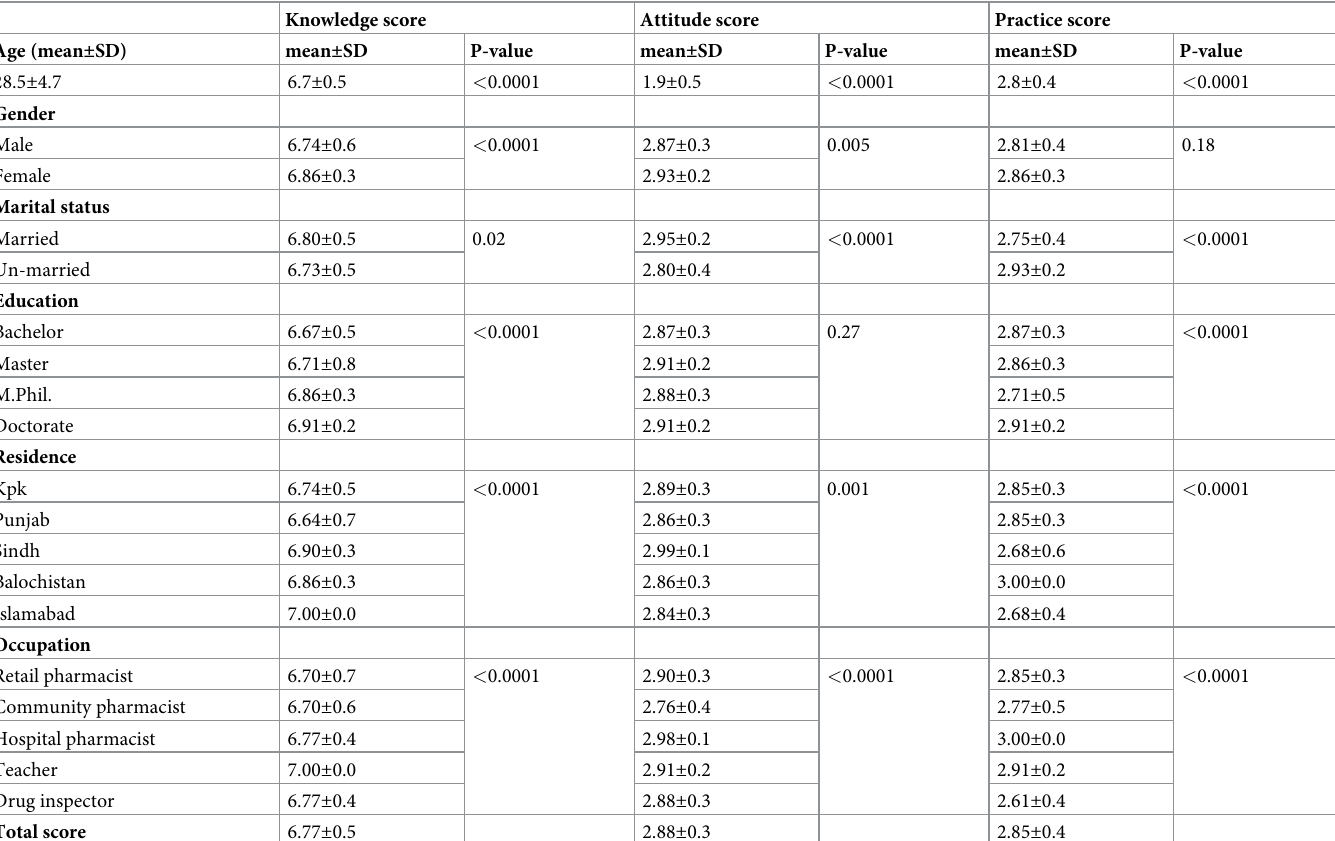
Table 2. Differences in pharmacist’s knowledge, attitude and practice scores regarding COVID-19 by demographic variables.